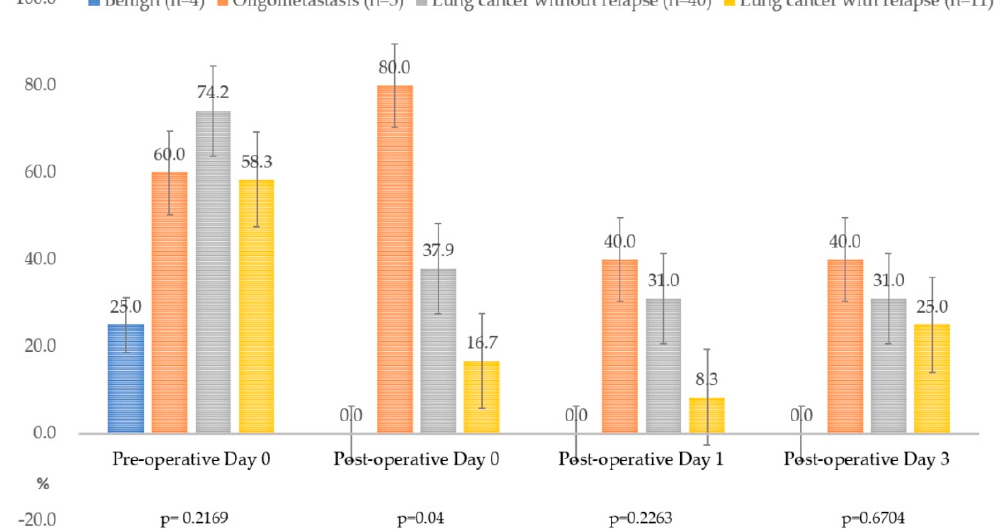
Figure 2. The positivity of circulating tumor cells (CTCs) in different clinical scenarios. The CTC positivity is not different among four subgroups before curative surgery and is statistically different immediately after the surgery (postoperative day 0, p = 0.04). A possible false positivity of 25.0% can be observed in the benign group (n = 4), but it goes down to zero after surgery. On the other hand, the CTC positivity of the oligometastasis group (n = 6) remains 40.0–80.0% though the operation has removed even the visible tumor(s).